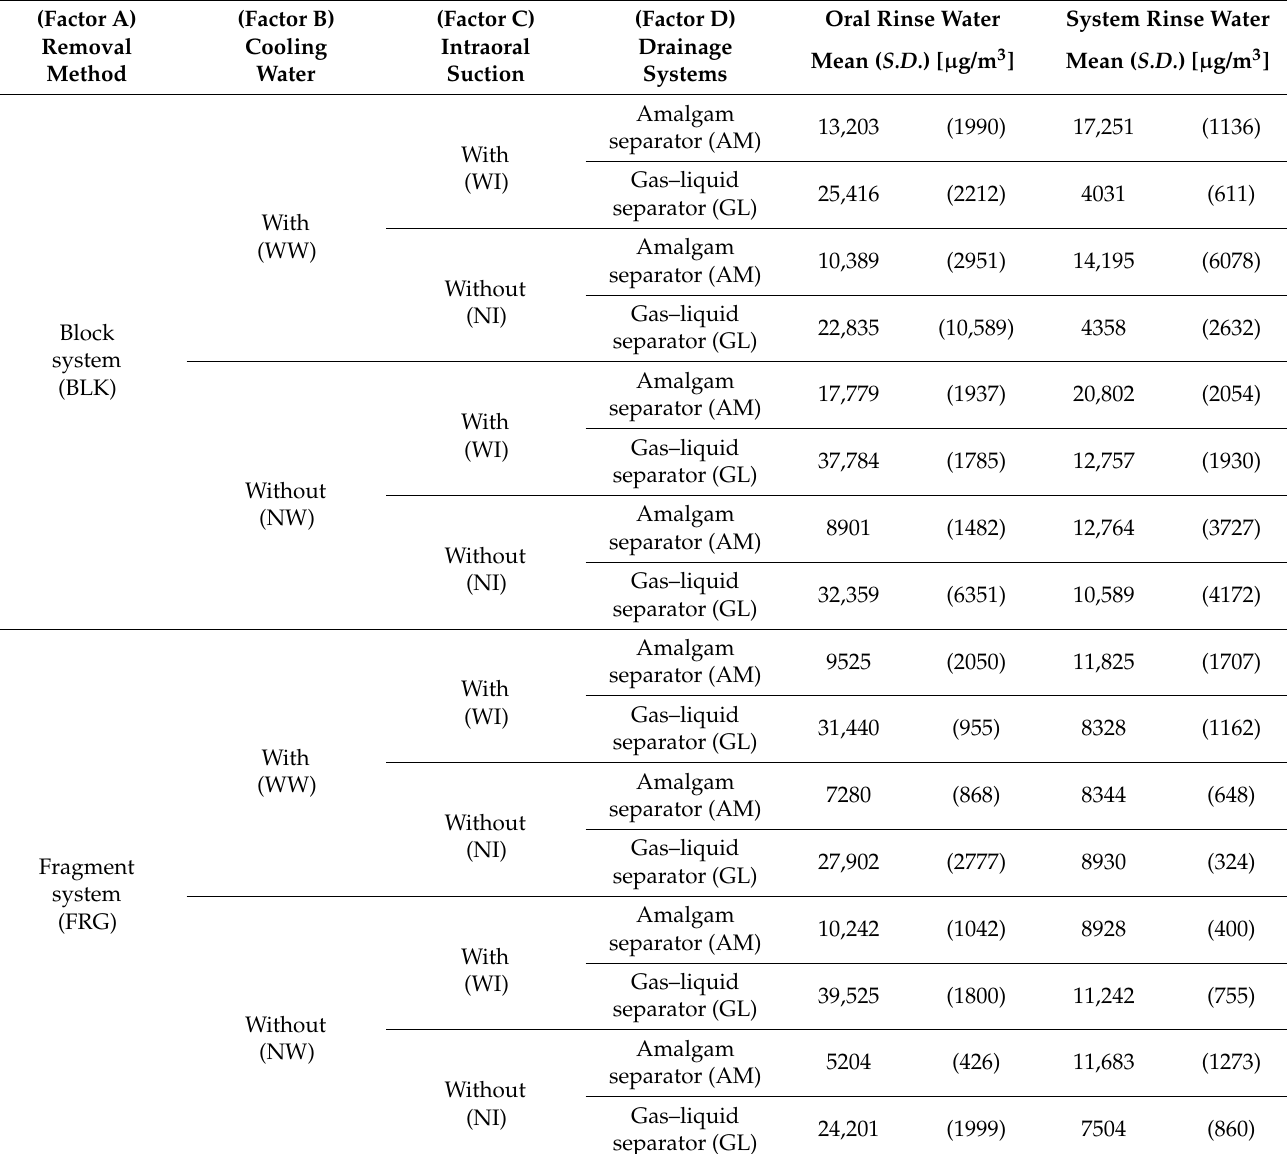
Table 1. The mean values and standard deviations of mercury amount in each